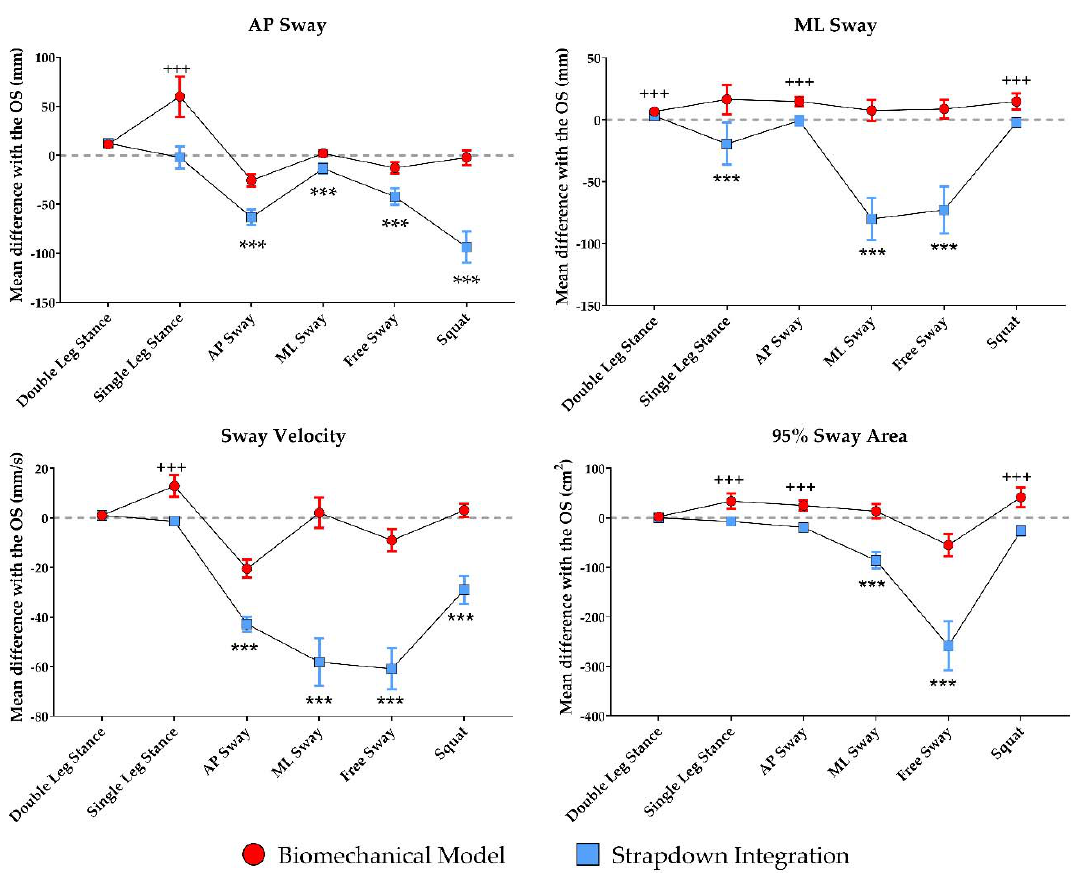
Figure 6. Errors (means and 95% Confidence Intervals) in the estimation of the analyzed kinematic parameters made by the Biomechanical Model and the Strapdown Integration method, using the Optoelectronic System (OS) as the reference, for each investigated task. The symbols indicate a statistically significant difference (p < 0.001) between the two methods when a higher absolute error is associated with the Biomechanical Model (+++) or the Strapdown Integration method (***).